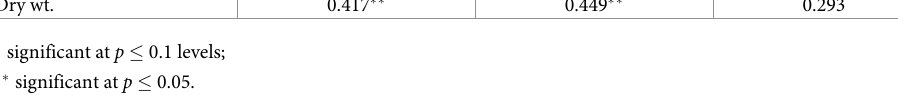
Table 4. Correlation coefficients showing the relationship between Simpson’s diversity Index (SDI), Shannon’s Index (SI) and Richness Index (RI) with biomass in the Yellow River Delta Nature Reserve wetlands. SDI SI RI Fresh wt. 0.318 � 0.335 � 0.230 Dry wt.